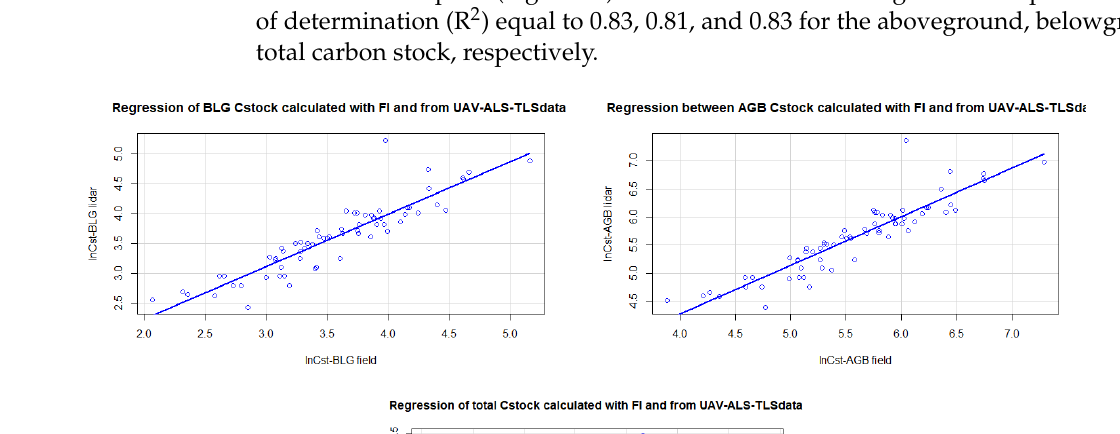
Table 7. Aboveground, belowground, and total biomass and carbon stock (Mg/ha) by plot and their mean, minimum, and maximum in the six plots.